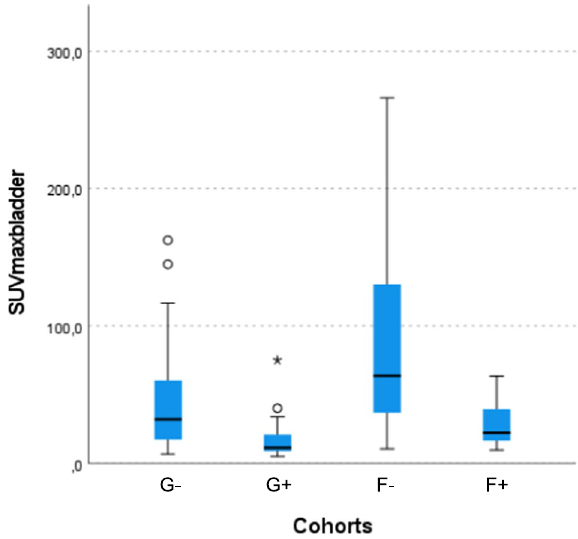
, F‑ and F of SUVmax bladder using the Kruskall‑Wallis test, and the results + +